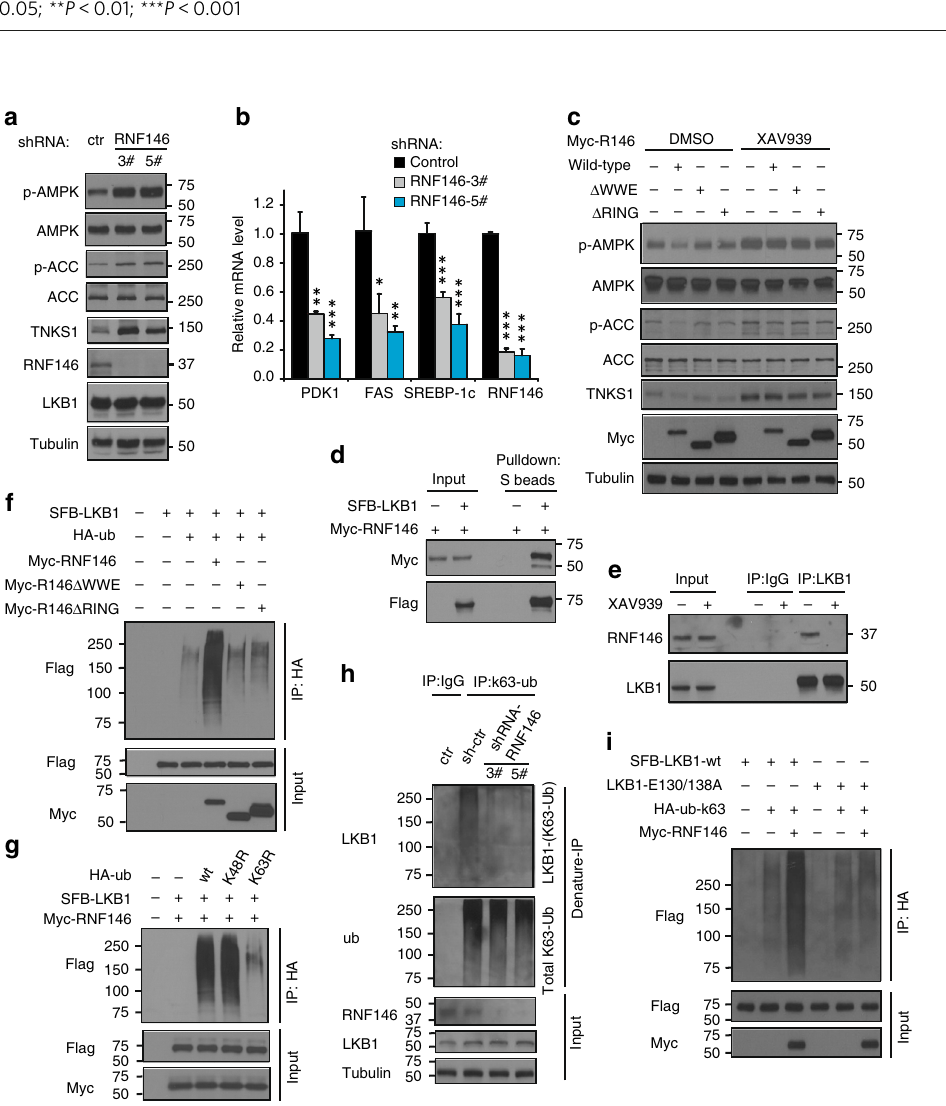
Fig. 2 LKB1 is Essential for Tankyrase-Mediated AMPK Regulation. a Expression of LKB1 in LKB1-de fi cient A549 cells restores G007-LK-induced AMPK activation. b G007-LK induced AMPK activation is impaired in LKB1-knockout cells. LKR13 and LKR13-LKB1-knockout cells were treated with the indicated inhibitors were subjected to western blotting. c , d Tankyrase inhibitor – induced suppression of cell growth ( c ) and colony formation ( d ) depends on LKB1. Cell proliferation and colony formation were measured as described above; data are presented as means ± SD ( n = 3 independent experiments). e The LKB1-E130/138 A mutant is resistant to tankyrase inhibitor – induced AMPK activation. HeLa cells stably expressing wild-type LKB1 or the LKB1-E130/138 A mutant were treated with XAV939 or G007-LK and the cell lysates were subjected to western blotting. f , g Tankyrase inhibitors have much less of an effect on suppression of cell growth ( f ) and colony formation ( g ) in HeLa cells expressing the LKB1-E130/138A mutant. Cell proliferation and colony formation were measured. h Schematic display of the LKR13 and LKR13-LKB1-knockout mouse xenograft experimental design. LKR13 (0.5 × 10 6 cells) and LKR13-LKB1-ko (0.25 × 10 6 cells) were implanted by injection. i , j Tumor volume ( i ) and weight ( j ) of mice from different treatment groups; data are presented as means ± SD ( n = 10 mice). k Tumor proteins from the indicated groups of mice were extracted, and lysates were examined by western blotting with the indicated antibodies. l Tumor weight of mice with subcutaneous injection of 2 × 10 6 indicated HeLa cells (mtLKB1 indicates LKB1-E130/ 138 A mutant) with vehicle or G007-LK were presented ( n = 6 mice, mean = ± SD). Statistical signi fi cance was determined by a two-tailed, unpaired